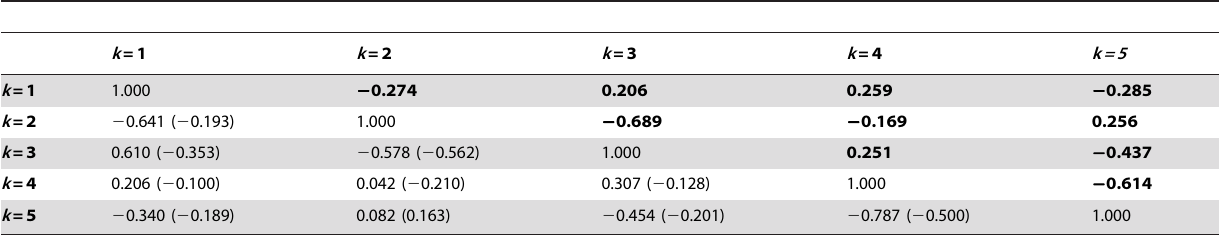
Table 1. Correlations between optimized force constants associated with contact orders of k # 5, indicative of compensating interactions between near neighbors along the